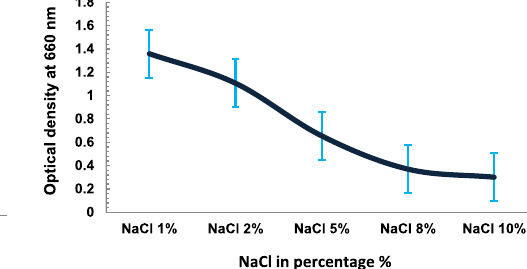
Fig. 3. Temperature Dependent growth of Kanchengayao glacier isolates